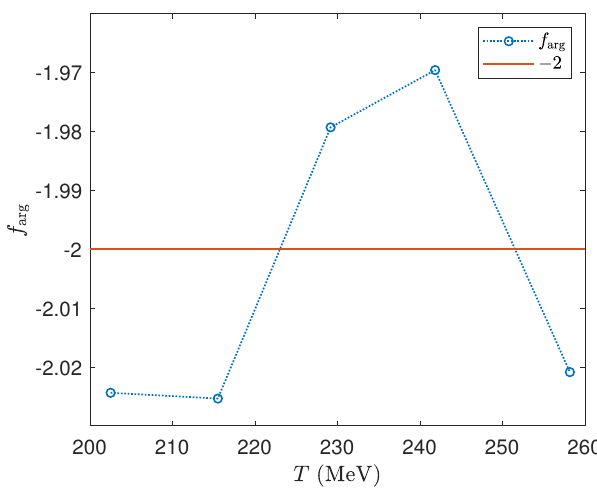
Figure 23 . f arg in eq. (3.11) as a function of temperature.